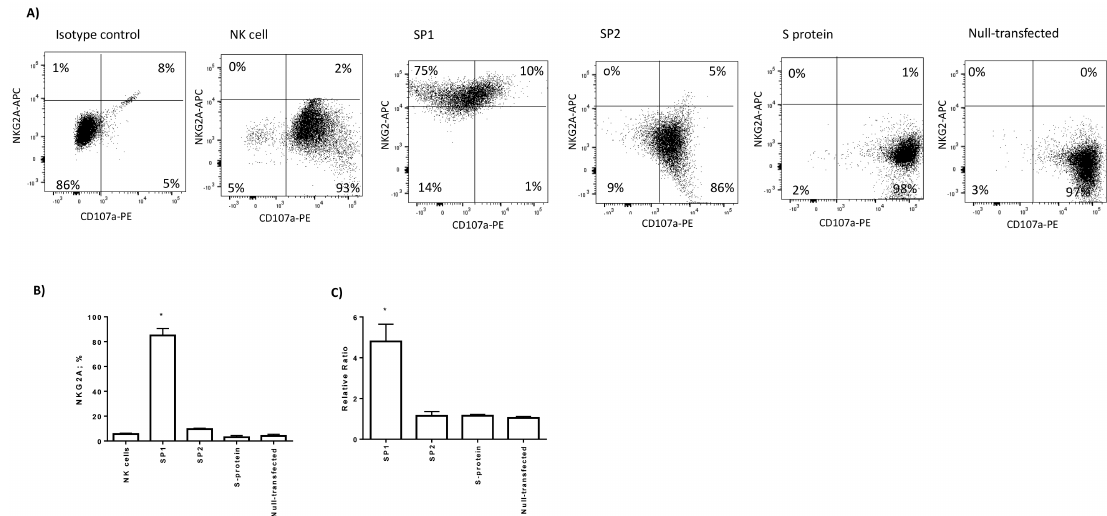
Figure 6. ( A ) Representative dot plots of NKG2A / CD94 and CD107a expression on the surface of NK cells after co-culture with Beas-2B transfected with SP1, SP2, and S proteins or control fluorescent antibody was used as a positive control (null-transfected). ( B ) The histograms show the mean ± standard deviation percentage of NKG2A / CD94-positive cells in three independent experiments. * significant p values Student t test. ( C ) Relative ratio of real-time PCR of NKG2A expression in transfected Beas-2B cells. * significant p values Student t test.